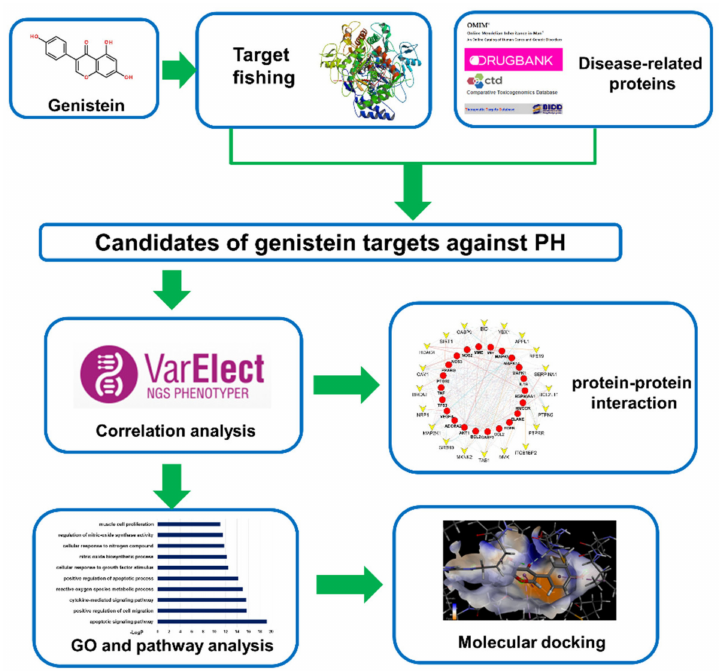
Figure 5. Work scheme of network pharmacology approach. PH: pulmonary hypertension; GO: Gene